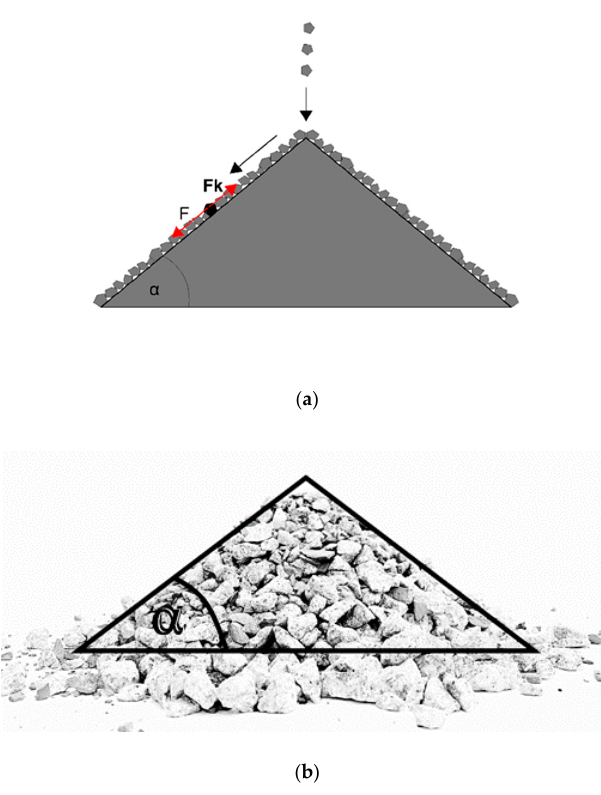
Figure 9. Cone experiment used to determine the coe ffi cient of dynamic friction of dolomite grains: ( a ) theoretical, ( b )